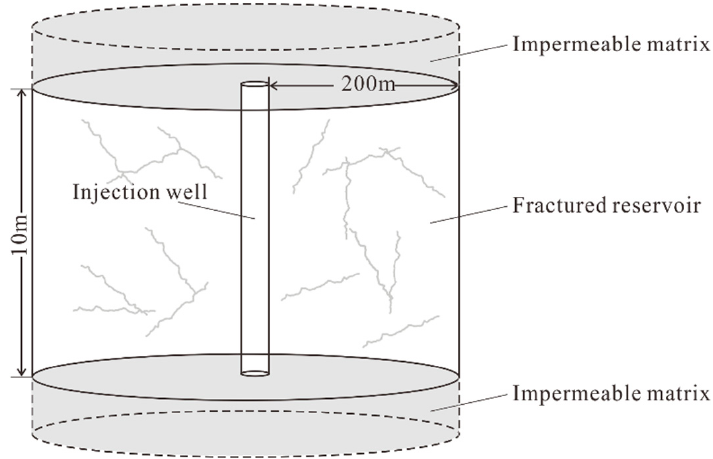
Figure 2. Conceptual model.